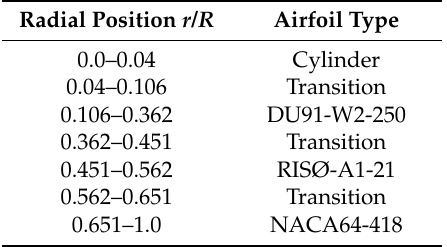
Table 1. Blade geometry profile of MEXICO rotor.